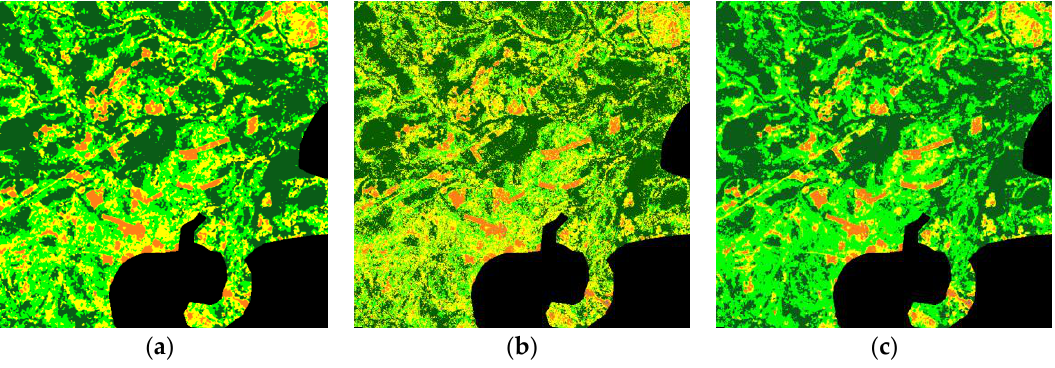
Figure 3. ( a ) Land cover ground-truth classification as published by Temudo et al. [2]; ( b ) Fuzzy-Fusion (FF)-Uninorm classification; ( c ) FF-Uninorm classification after applying a mean filtering.